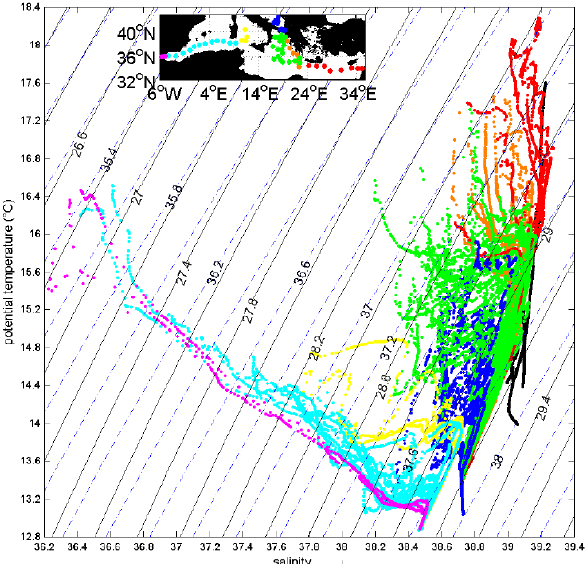
Figure 2b. T – S diagram of all CTD stations taken during cruise M84-3 and P414 in spring 2011. Values from 50m depth down to the bottom are considered. Colours show different regions of the Mediterranean Sea. Black dots: Aegean Sea, red dots: Lev- antine Sea, green dots: Ionian Sea, orange dots: Hellenic Trench, blue dots: Adriatic Sea, yellow dots: Tyrrhenian Sea, cyan dots: re- maining western Mediterranean Sea, magenta dots: Strait of Gibral- tar. Isolines for potential density σ 0 = ρ 0 (referenced to sea sur- face) − 1000kgm − 3 (black continuous line) and for potential den- sity σ 2 = ρ 2000 (referenced to 2000m) − 1000kgm − 3 (blue dashed line) are given. Inset panel shows the location of the different sta-